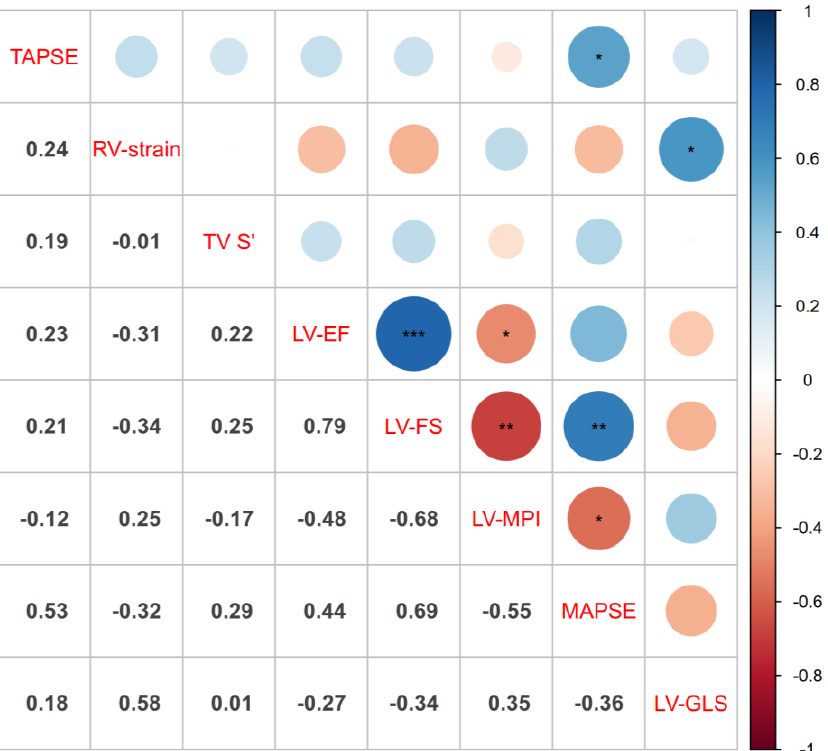
Figure 6. Correlation matrix: the size of the circles on the right side of the matrix correspond to more correlation, positive or negative (color code: blue positive and red negative correlation); the corresponding r values are displayed on the left side of the matrix. “*” corresponds to the calculated significance levels: * = p ≤ 0.05, ** = p ≤ 0.01, *** = p ≤ 0.001. Note that higher values of LV-MPI indicate cases with DCM, and that strain values are negative, i.e., values closer to zero indicate reduced, and more negative values better myocardial strain. For the remainder of displayed parameters, more positive values indicate better ventricular function.